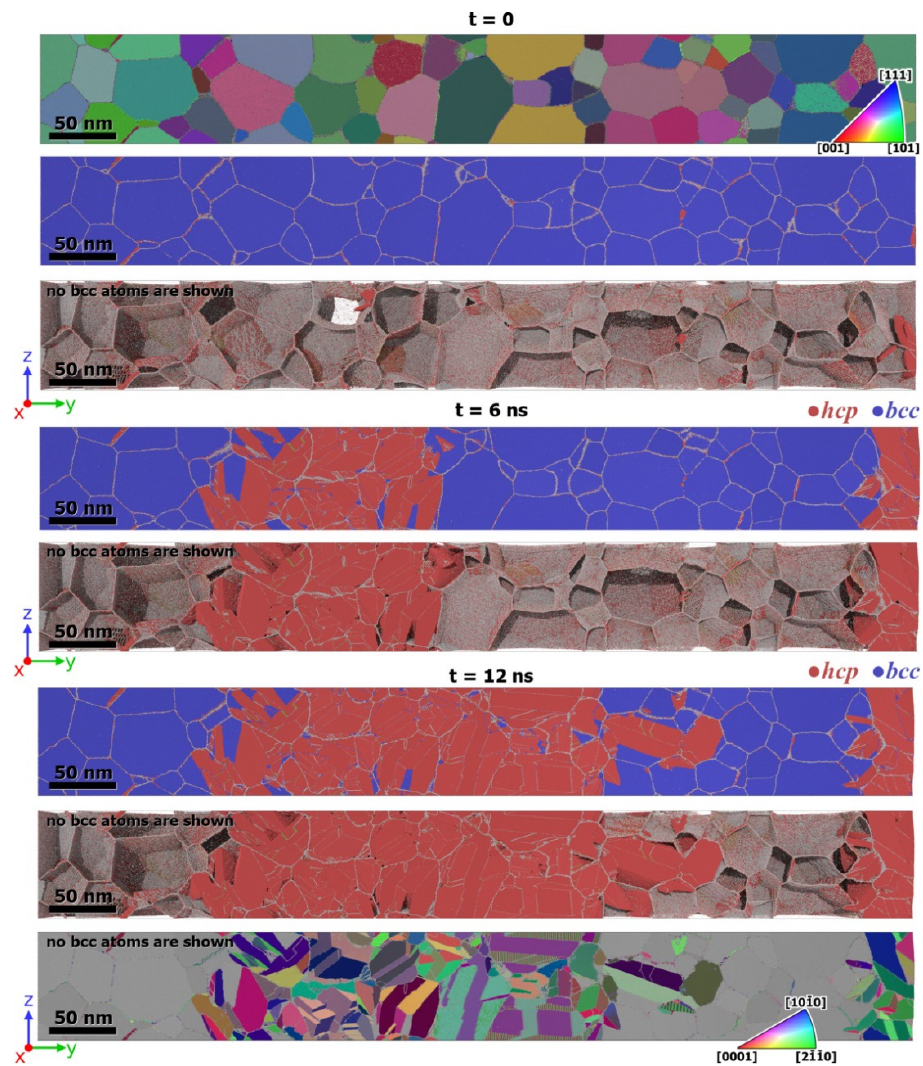
Fig. 2. Destruction of the metastable β phase (β→α martensitic transition) in the fine grain sample during cooling from T =600 K down to room